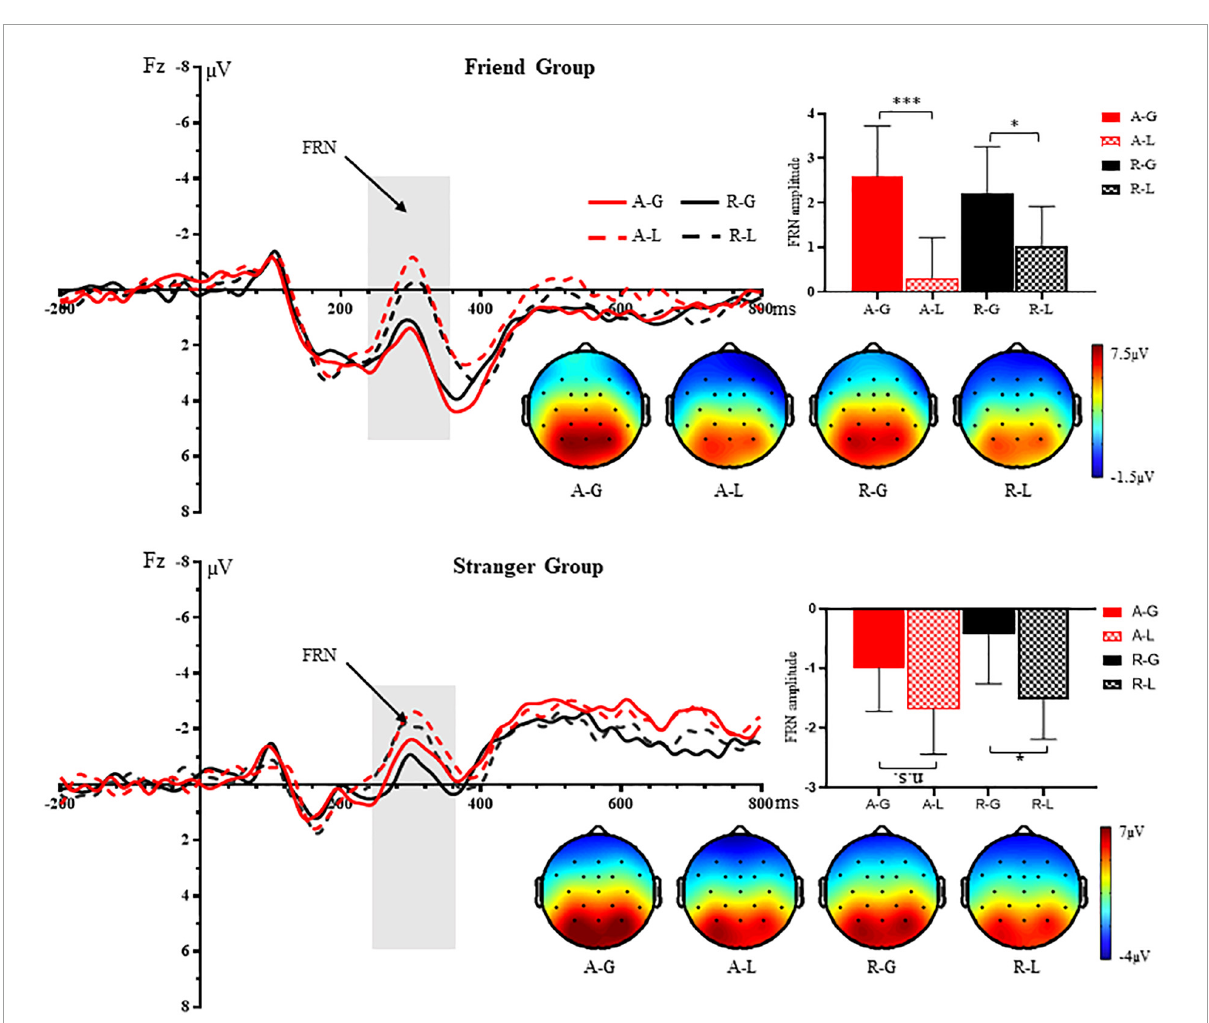
FIGURE2 Grand-averaged waveforms, amplitudes and topography from 240 to 360 ms at the Fz electrode in response to four combinations of outcome feedbacks following the advisee’s decisions: acceptance and receiving a gain (A-G), acceptance and receiving a loss (A-L), rejection and receiving a gain (R-G), and rejection and receiving a loss (R-L) in the friend group and the stranger group, respectively. ∗ p < 0.05, ∗∗∗ p < 0.001. n.s. =